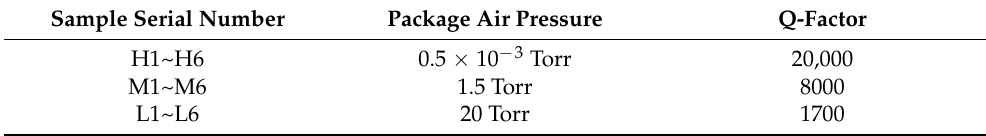
Table 1. Design values of package air pressure and Q-factor for three kinds of samples.